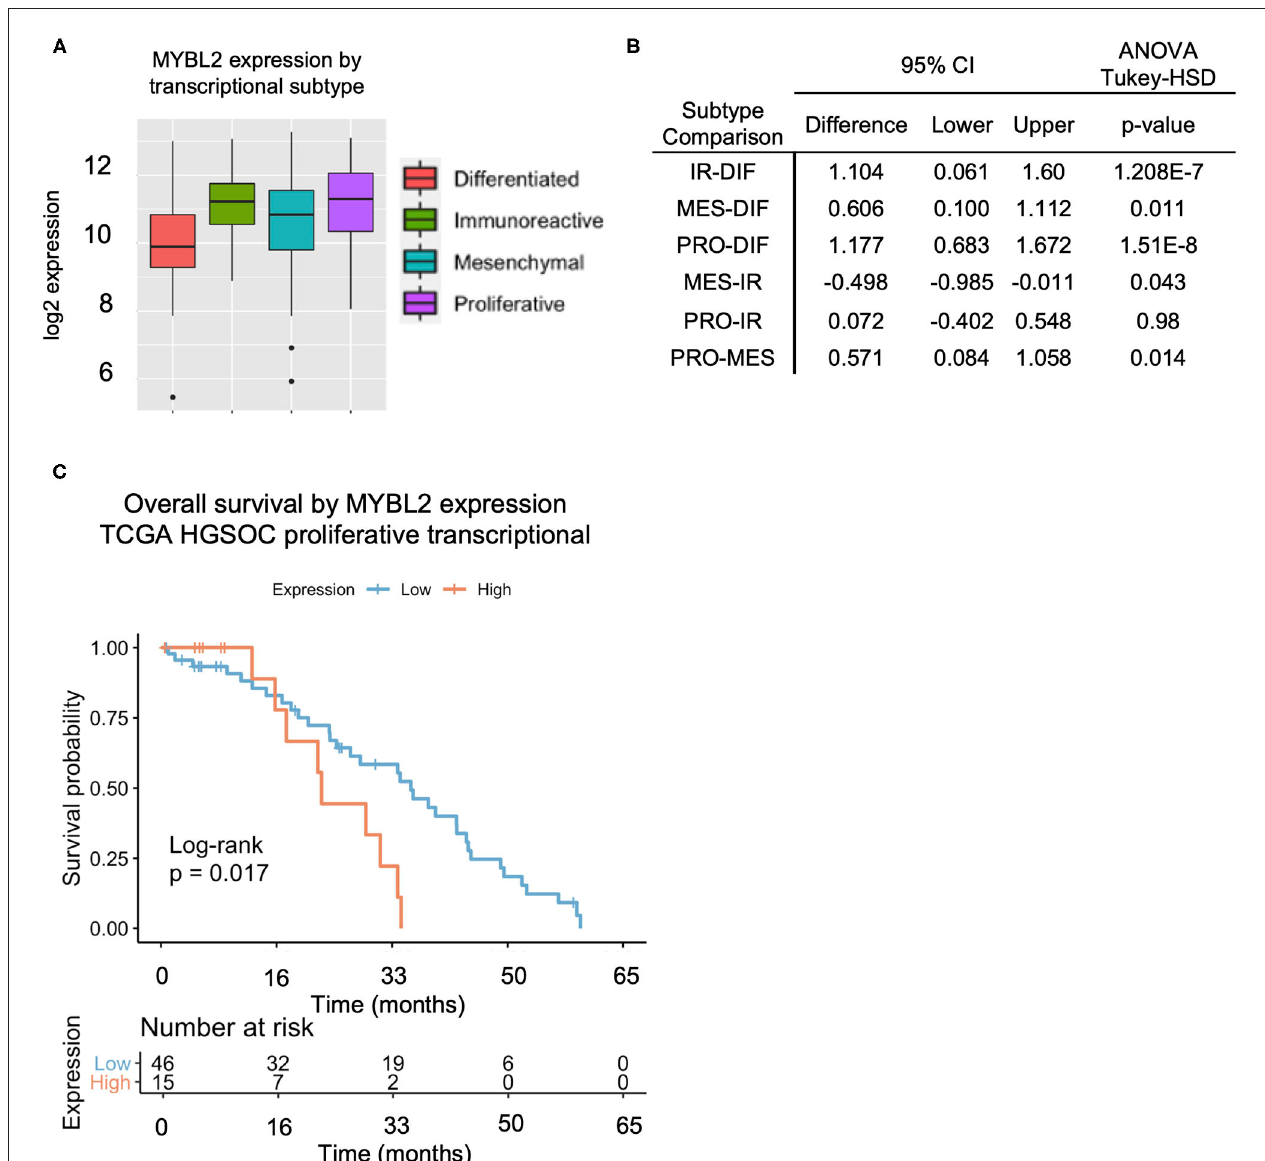
FIGURE 2 | The proliferative subtype HGSOC exhibits the highest MYBL2 expression across transcriptional subtypes. (A,B) Comparison of MYBL2 expression across transcriptional subtypes (ANOVA with Tukey-HSD post-test , p < 0.01) with highest expression in the proliferative subtype. IR, Immunoreactive ( N = 78); DIF, Differentiated ( N = 67); MES, Mesenchymal ( N = 71); PRO, Proliferative ( N = 78). (C) High MYBL2 expression is associated with a significantly worse prognosis in HGSOC ( Figure 1 ) with a similar trend shown here in the proliferative subtype from TCGA data analysis. Data show Kaplan–Meier curves and Cox proportional hazard